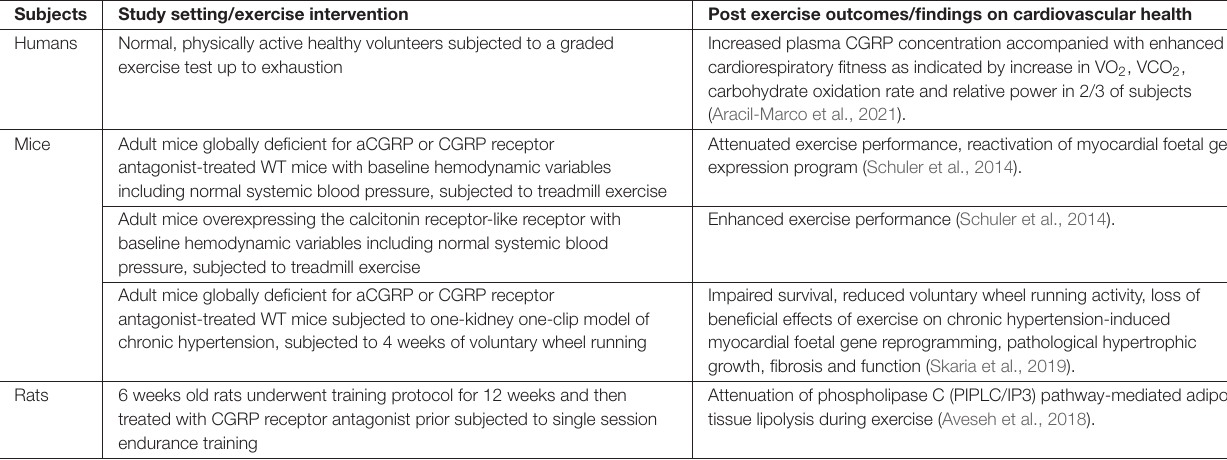
TABLE 1 | Cardiovascular effects of exercise-activated endogenous, aCGRP signaling. Subjects Study setting/exercise intervention Post exercise outcomes/findings on cardiovascular